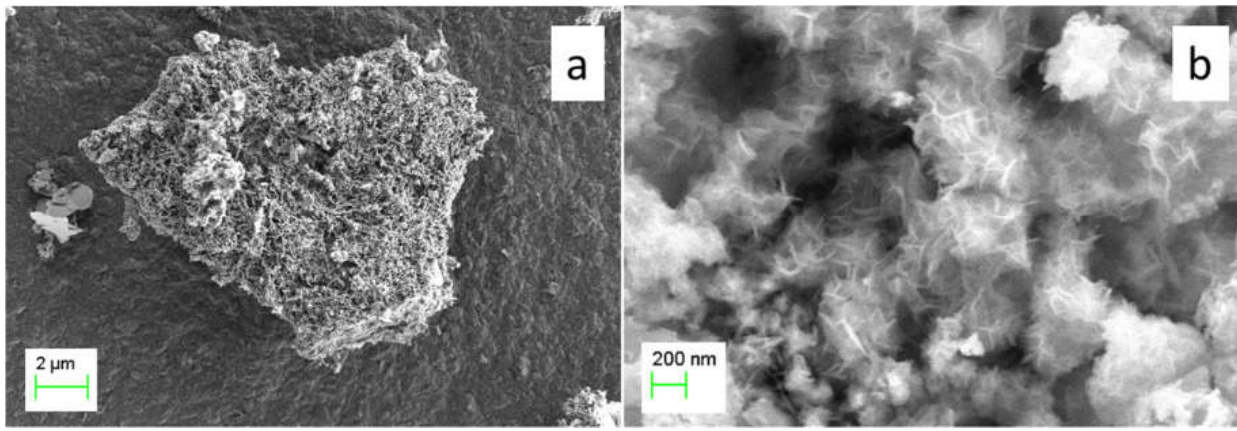
Figure 1. Scanning electron microscopy (SEM) images of synthetic MnO 2 at ( a ) 8310x magnification and ( b ) 50,000x magnification.